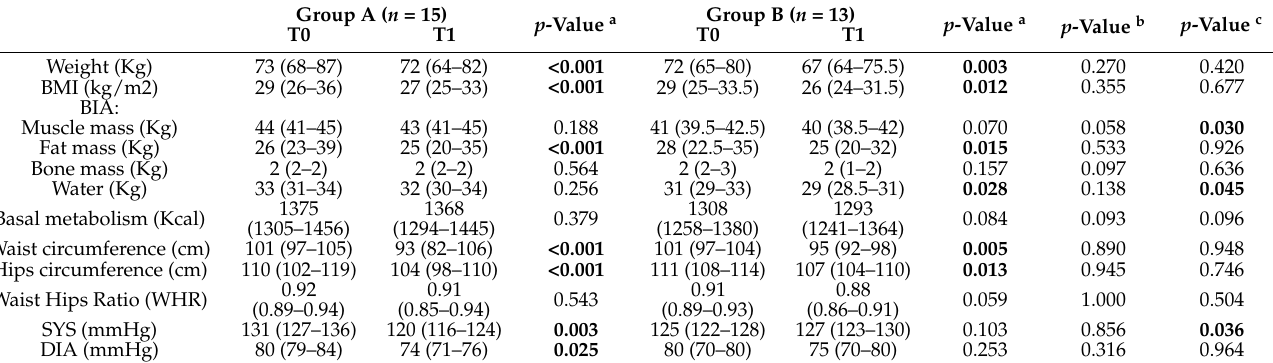
Table 1. Anthropometric measures of recruited patients in groups A and